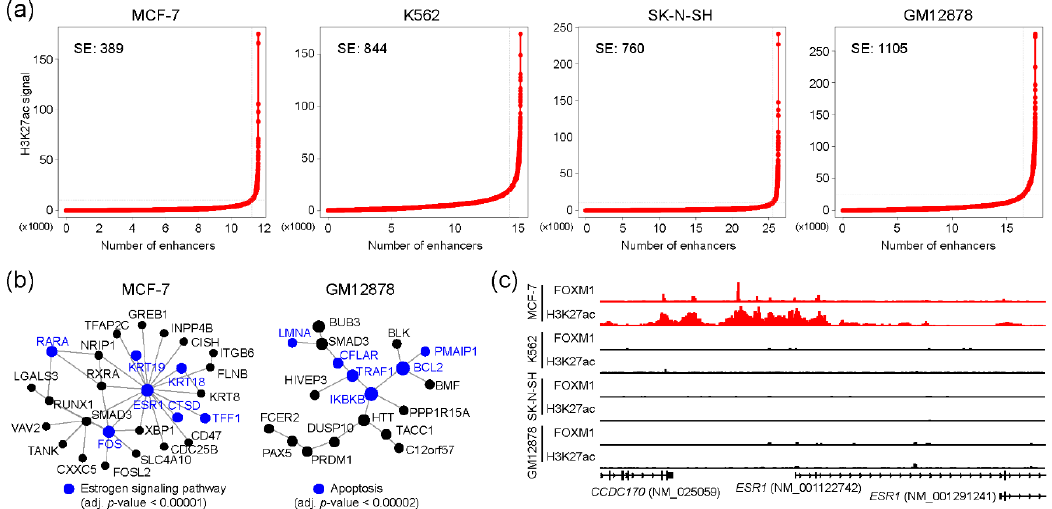
Figure 4. FOXM1 binding sites associated with super-enhancers. ( a ) Super-enhancer line plots indicate the number of identified super-enhancers using H3K27ac-enriched regions. ( b ) Protein–protein interaction networks were constructed using NetworkAnalyst. Genes around the top 300 FOXM1 binding sites (ranked by the height of the peaks) were used for the analysis. ( c ) FOXM1 binding and H3K27ac enrichment near the ESR1 gene is shown.